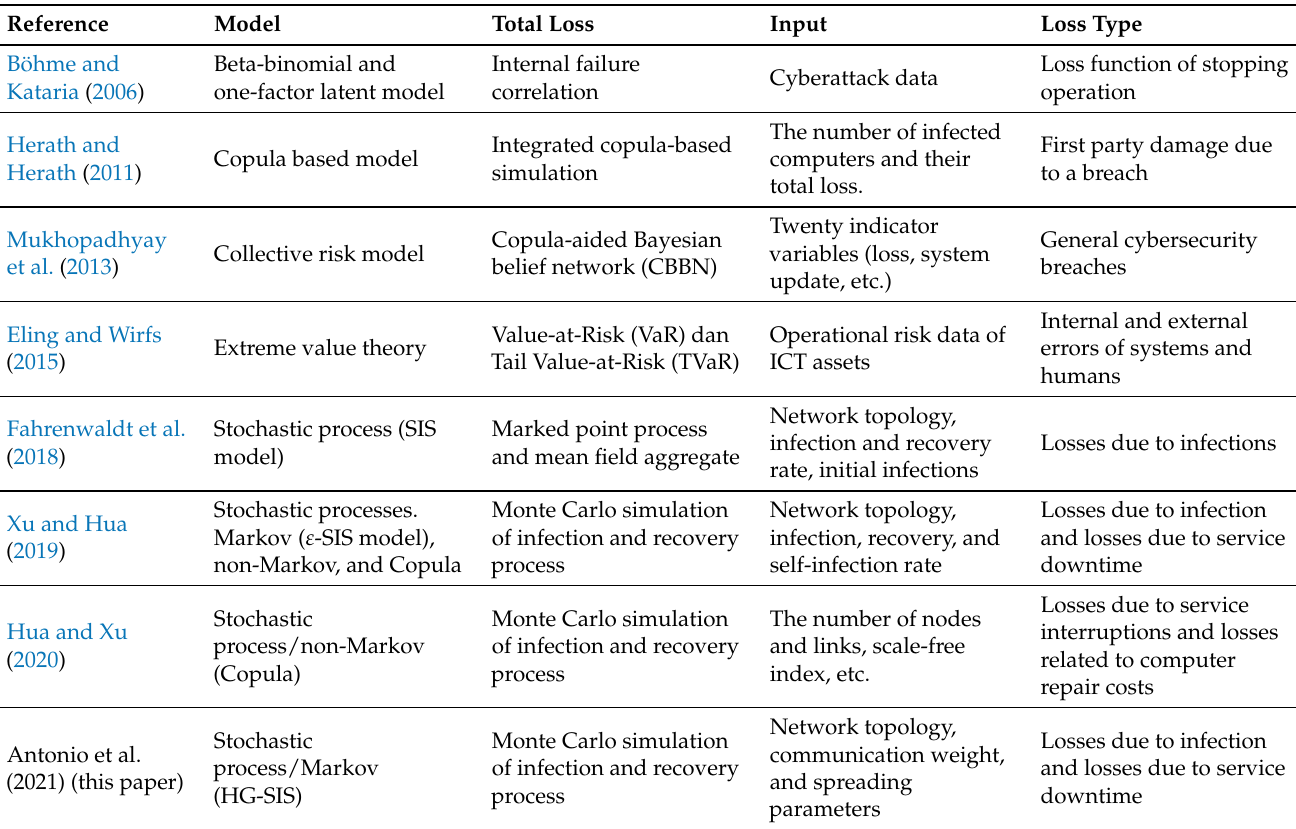
Table 1. Comparison of the CIRM model. The-state-of-the-art of our proposed model, total loss, model input, and loss type. Reference